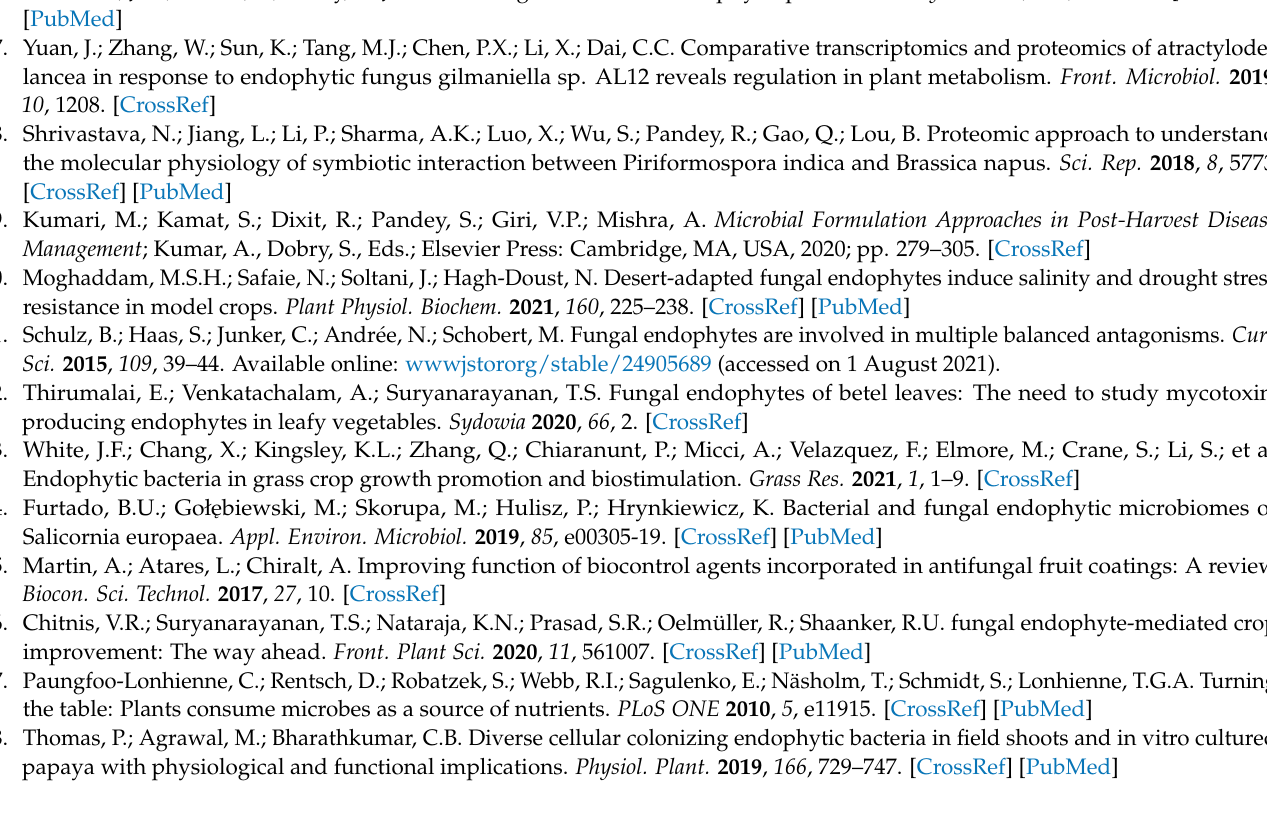
the table: Plants consume microbes as a source of nutrients. PLoS ONE 2010 , 5 , e11915. [CrossRef]